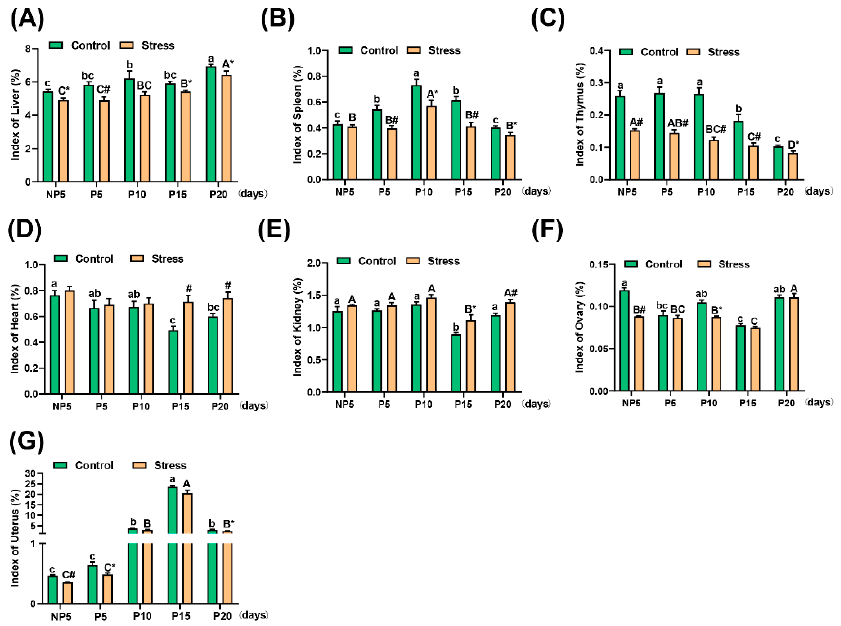
Figure 2. Effect of restraint stress on organ index in pregnant mice. The liver, spleen, kidney, heart, ovary, uterus, and thymus were weighed. The organ index was expressed as the ratio of the weight of the organ to the body weight. The result showed that restraint stress caused a significant decrease in the organ index of the liver ( A ), spleen ( B ), thymus ( C ), ovary ( F ), and uterus ( G ), indicating that restraint stress affects the immune system, the digestive system, and the reproductive system. At the same time, the heart ( D ) index and kidney ( E ) index increased under restraint stress. In general, restraint stress may affect the function of the various systems of the body. The data were expressed as the mean ± SEM. Non-Pregnancy Day 5 (NP5) (n stress = 10, n control = 10), Pregnancy Day 5 (P5) (n stress = 10, n control = 10), Pregnancy Day 10 (P10) (n stress = 10, n control = 10), Pregnancy Day 15 (P15) (n stress = 10, n control = 10), and Pregnancy Day 20 (P20) (n stress = 10, n control = 10). Lowercase letters in the column (a, b, c) represented the differences between NP5, P5, P10, P15, and P20 in the control group ( p < 0.05), and uppercase letters in the column (A, B, C, D) represented the differences between NP5, P5, P10, P15, and P20 in the stress group ( p < 0.05). *p < 0.05 and #p < 0.01 were used to denote the significance of the stress group compared with the corresponding control group.